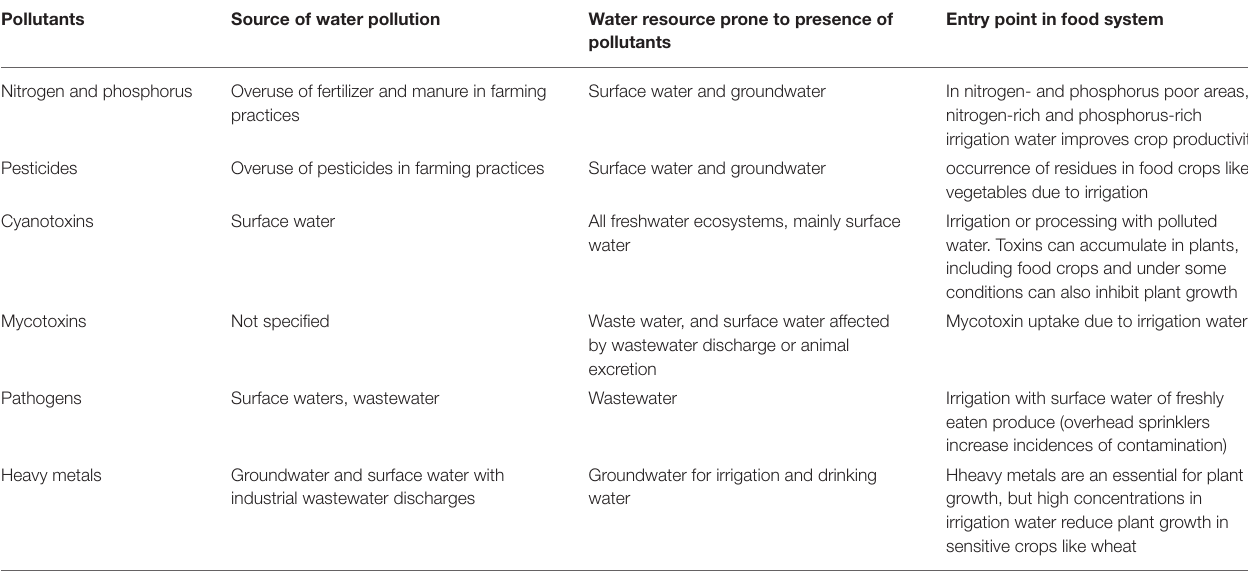
TABLE 1 | Type of water contamination related to